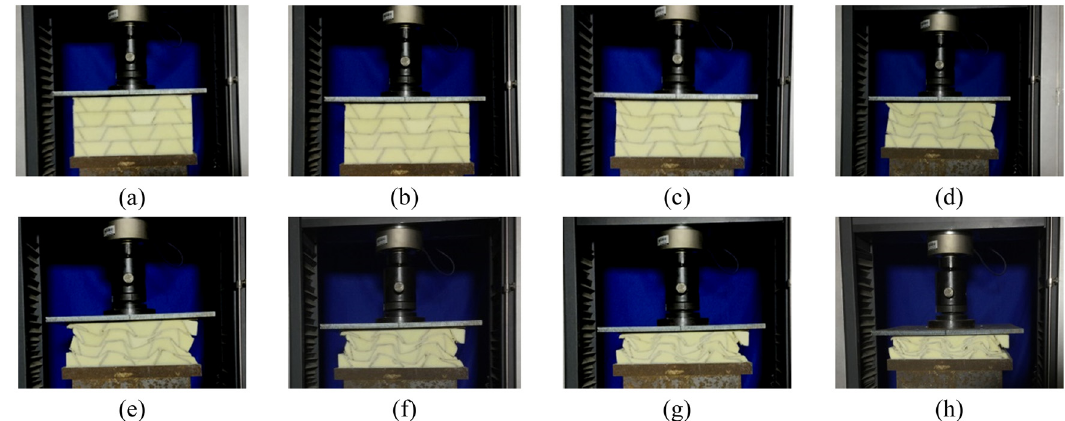
Figure 7: Quasi - static experiment of TS - T - A60: ( a ) beginning, ( b ) Δ = 15 mm, ( c ) Δ = 30 mm, ( d ) Δ = 45 mm, ( e ) Δ = 60 mm, ( f ) Δ = 75 mm, ( g ) Δ = 90 mm, ( h ) Δ = 105